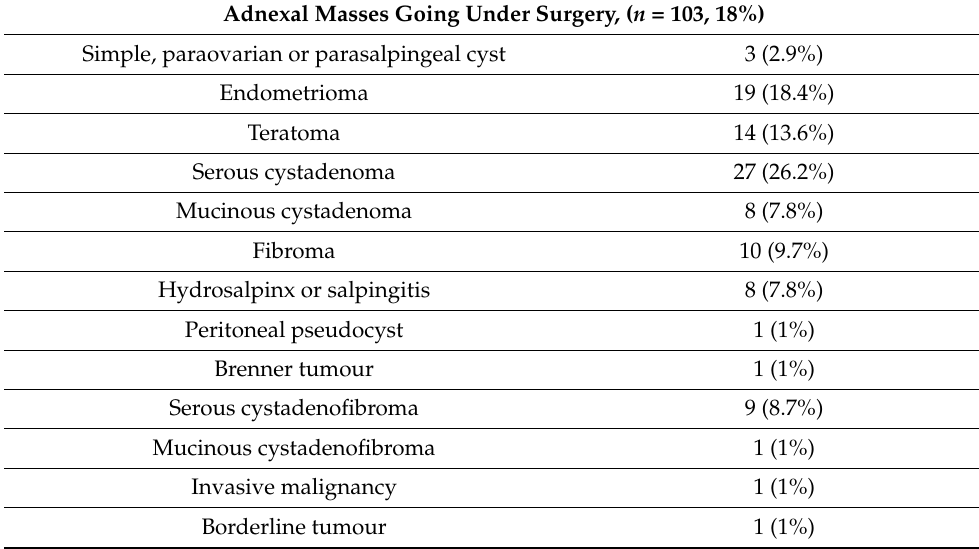
Table 6. Histological diagnosis of surgically removed adnexal masses. Adnexal Masses Going Under Surgery, ( n = 103, 18%) Simple, paraovarian or parasalpingeal